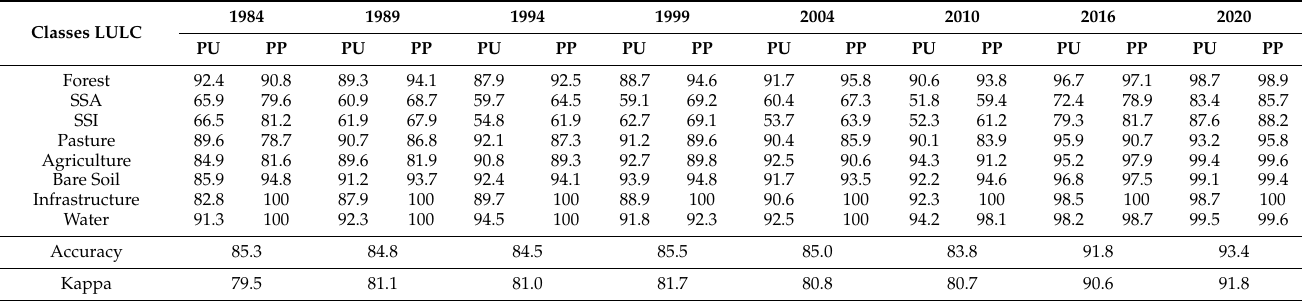
Table 1. Evaluation of the accuracy of the LULC classification in the Machadinho and Anari settlements. Classes LULC